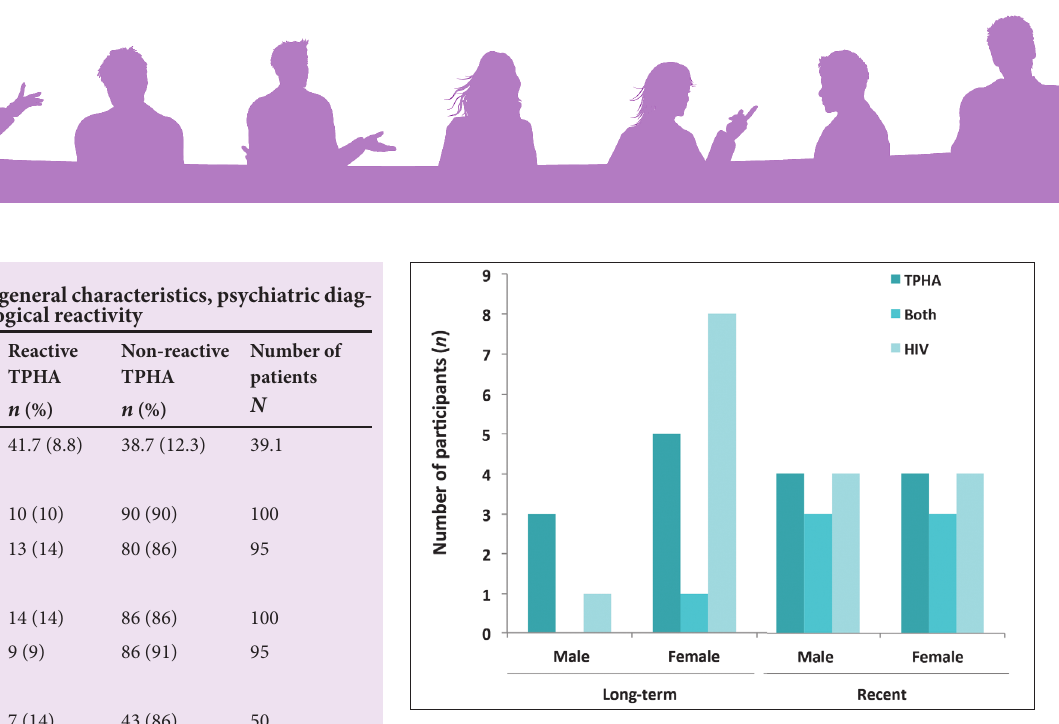
Fig. 1. Distribution of gender and length of admission (recent or long-term) in patients with syphilis (TPHA-positive) and/or